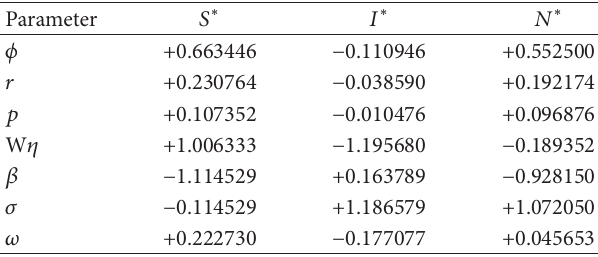
Table 3: Sensitivity indices of 𝐸 ∗ with 𝜙 = 0.2